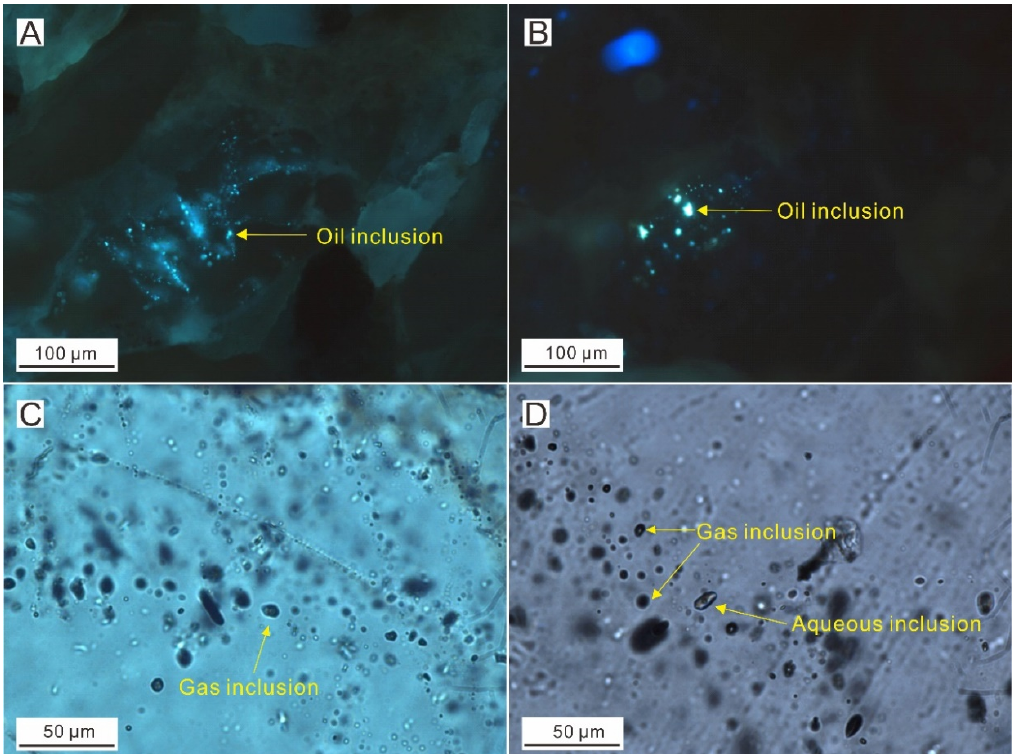
Figure 6. Photomicrographs of the hydrocarbon inclusions from the Lower Shihezi Fm. in the Hangjinqi area, north Ordos Basin. ( A ) Oil inclusions with blue fluorescence under ultraviolet light, Well J77, 2698.75 m; ( B ) Oil inclusions with blue-green fluorescence under ultraviolet light, Well J77, 2698.75 m; ( C ) Gas inclusions with dark grey color under transmitted light, Well J77, 2709.65 m; ( D ) Gas inclusion and coeval aqueous inclusion under transmitted light, Well J62, 3468.78 m. Table 2. Characteristics of the hydrocarbon inclusions from the Lower Shihezi Fm. in the Hangjinqi area, north Ordos Basin. GI: gas inclusion; OI: oil inclusion; AI: aqueous inclusion.